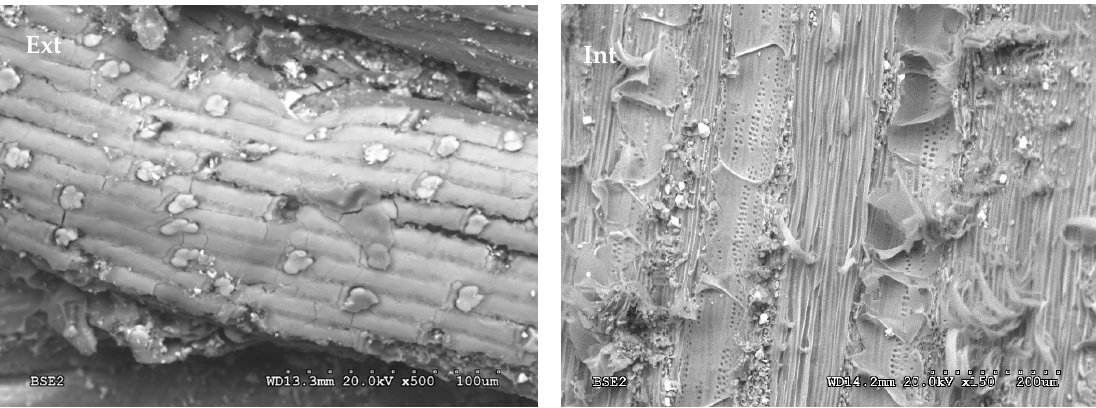
Figure 3. Micrograph of the outer ( ext ) and inner ( int ) surface of the giant reed.